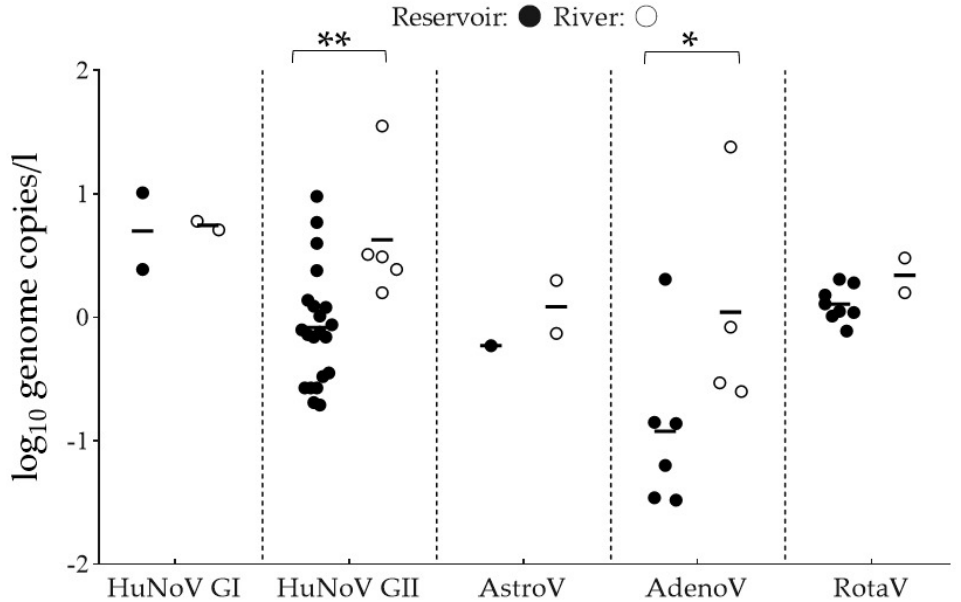
Figure 2. Average viral loads of foodborne viruses detected in the reservoirs and Anseong River. ● and ○ indicate reservoir and river samples, respectively. – means average viral loads. ** p < 0.01; * p < 0.05.